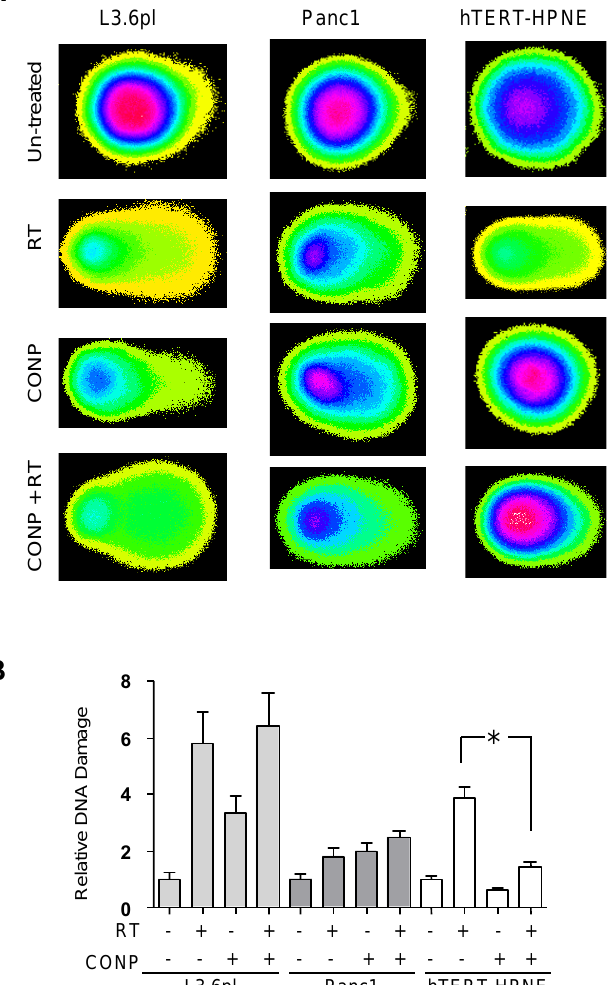
Figure 1. CONPs Do Not Sensitize Pancreatic Cancer Cells to RT via DNA Damage. Cells were treated with 10 μM CONPs followed by exposure to 0 or 5 Gy RT 24 hours later. Immediately after RT, cells were collected for Comet assay. ( A ) L3.6pl and Panc1 cells show DNA damage resulting from RT, but CONPs did not significantly alter DNA damage patterns, whereas hTERT-HPNE cells were protected from RT-induced DNA damage by pre-treatment with CONPs. ( B ) At least 50 cells per condition were analyzed and graphed relative to the respective (untreated) control. * p < 0.001.